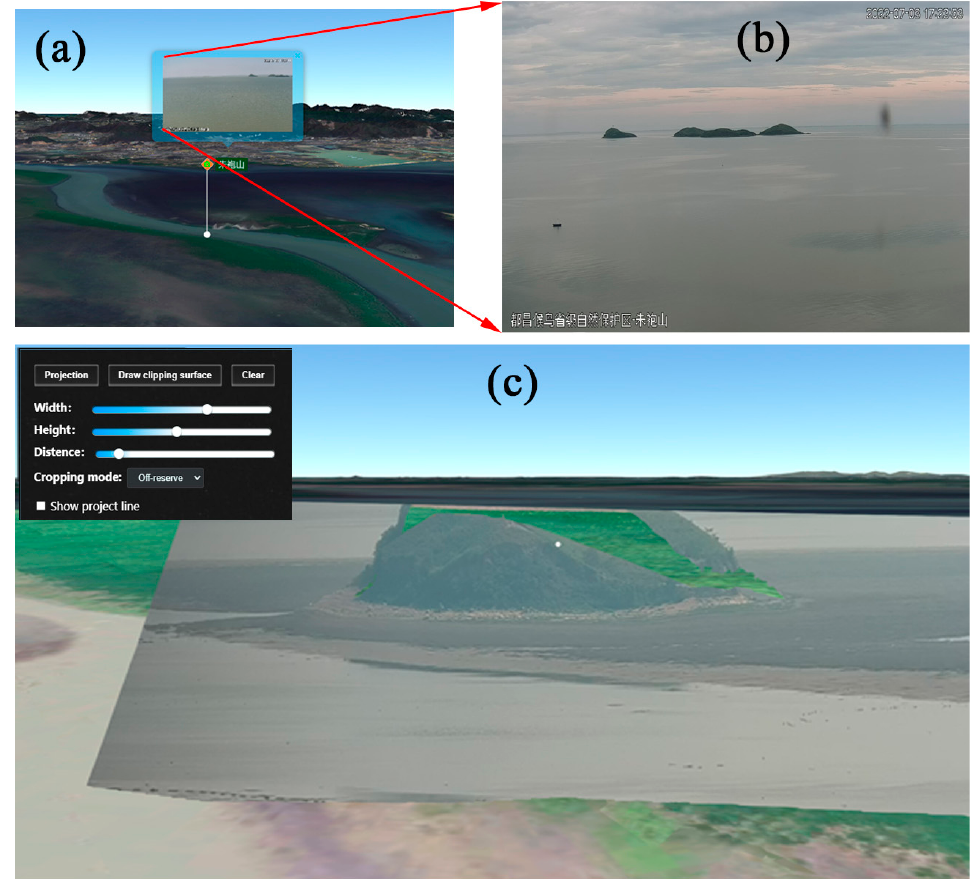
Figure 9. Visualization of environmental sensing video surveillance data: ( a ) video visualization under the billboard mode in the DT world of Poyang Lake; ( b ) real-time monitoring picture of Poyang Lake; and ( c ) video visualization under the projection video mode in the DT world of Poyang Lake.